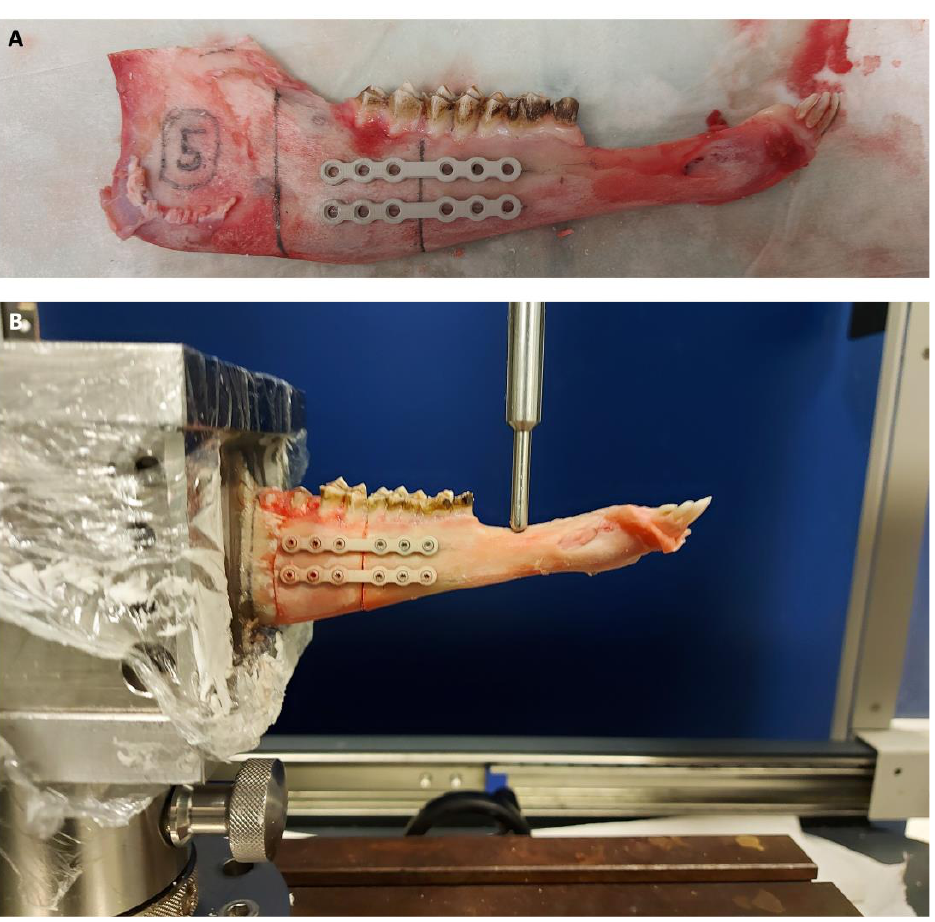
Figure 2. ( A ) Preparation of the half mandible for testing. The periosteum was completely detached, and markings for correct plate placement and the embedding section were applied. A notch for the pole (0.5 cm ∅ ) applying the force was placed in the diastema with a defined distance of 4.5 cm from the osteotomy to ensure a reproducible application of the force. ( B ) Embedded sample in the materials testing machine (Z010 AllroundLine, ZwickRoell) shortly after the force application started.